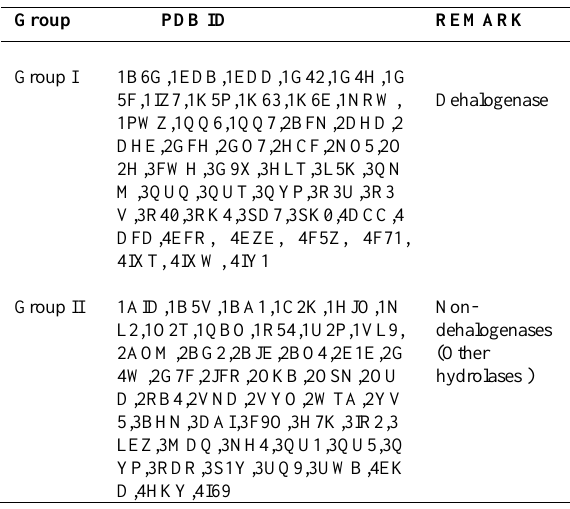
Table 1. PDBID of considered proteins for data set